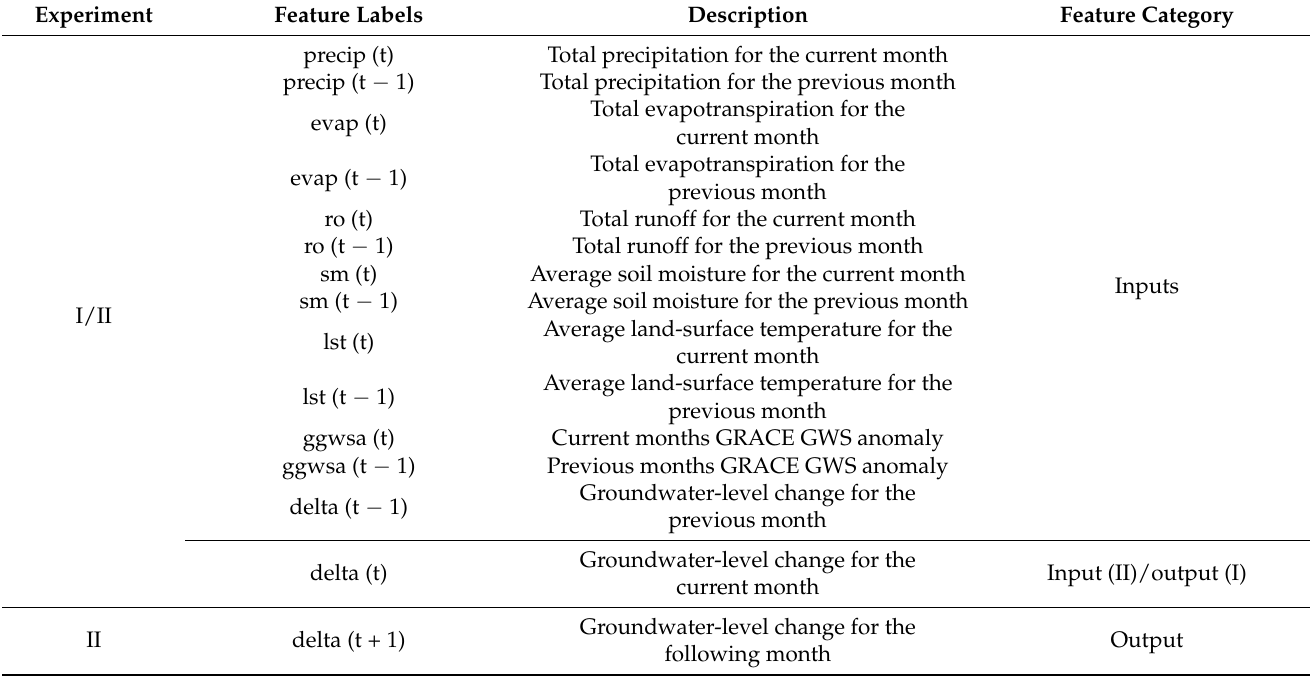
Table 2. Summary of predictor and predictant features used for model training and testing. Experiment Feature Labels Description Feature